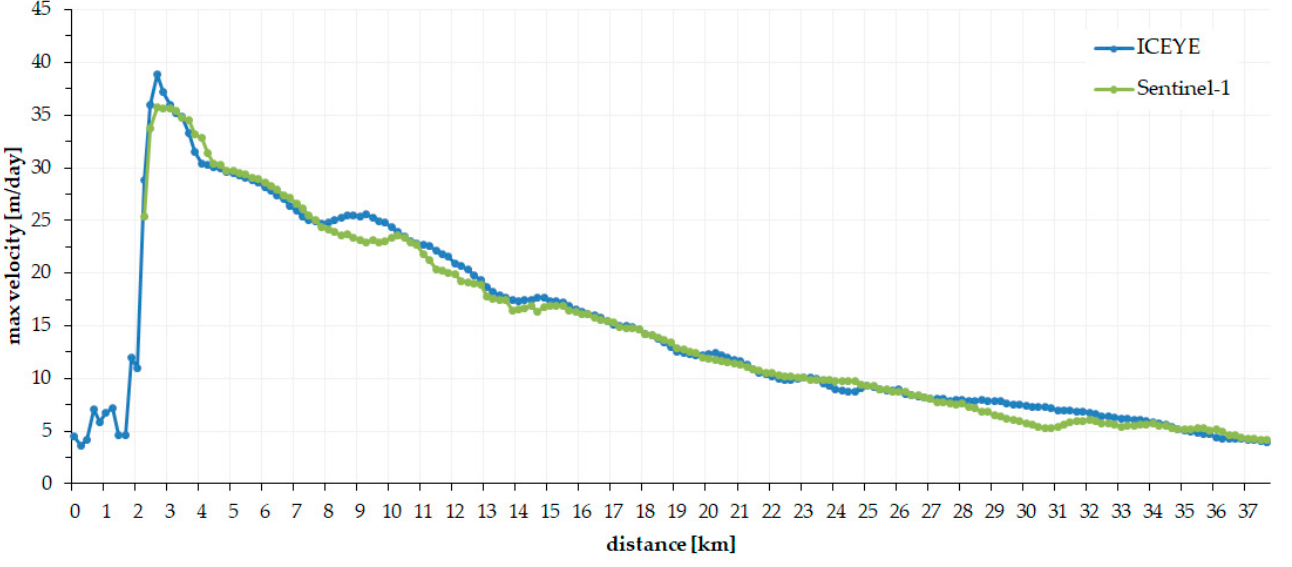
Figure 6. Velocities along the glacier profile from Sentinel-1 and ICEYE data.